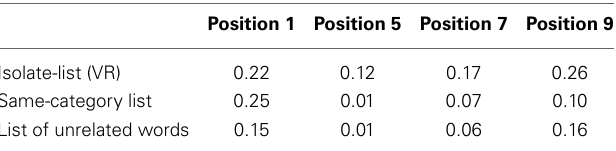
Table 5 | Probability of first recall for the isolate item only in different embedding lists (Experiment